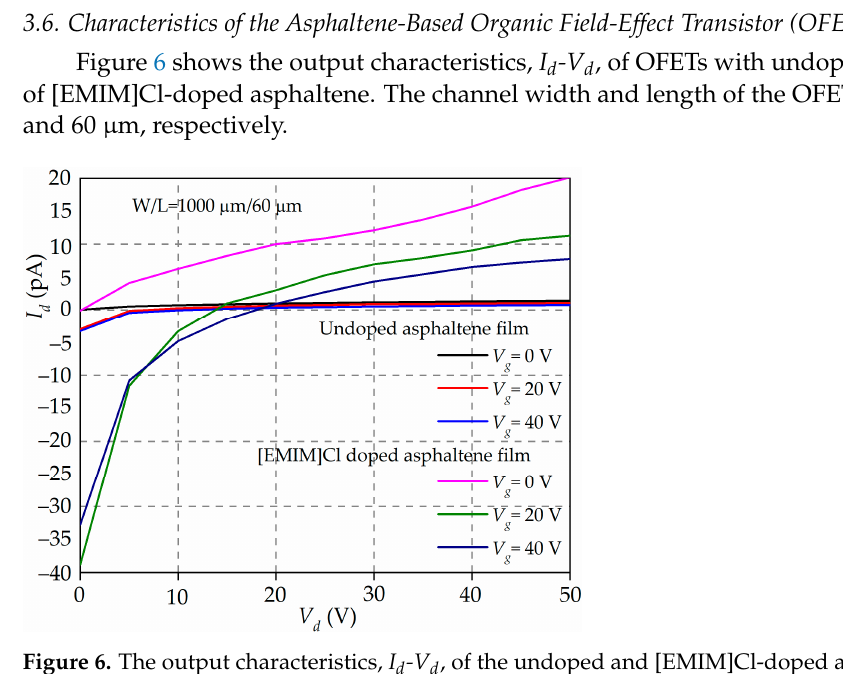
Figure 6. The output characteristics, I d -V d , of the undoped and [EMIM]Cl-doped asphaltene OFET bias at V g = 0, 20, and 40 V. The I d for [EMIM]Cl-doped asphaltene appears a few orders of magnitude higher than the I d for undoped OFET, except near the transition points where the I d change from negative to positive current.